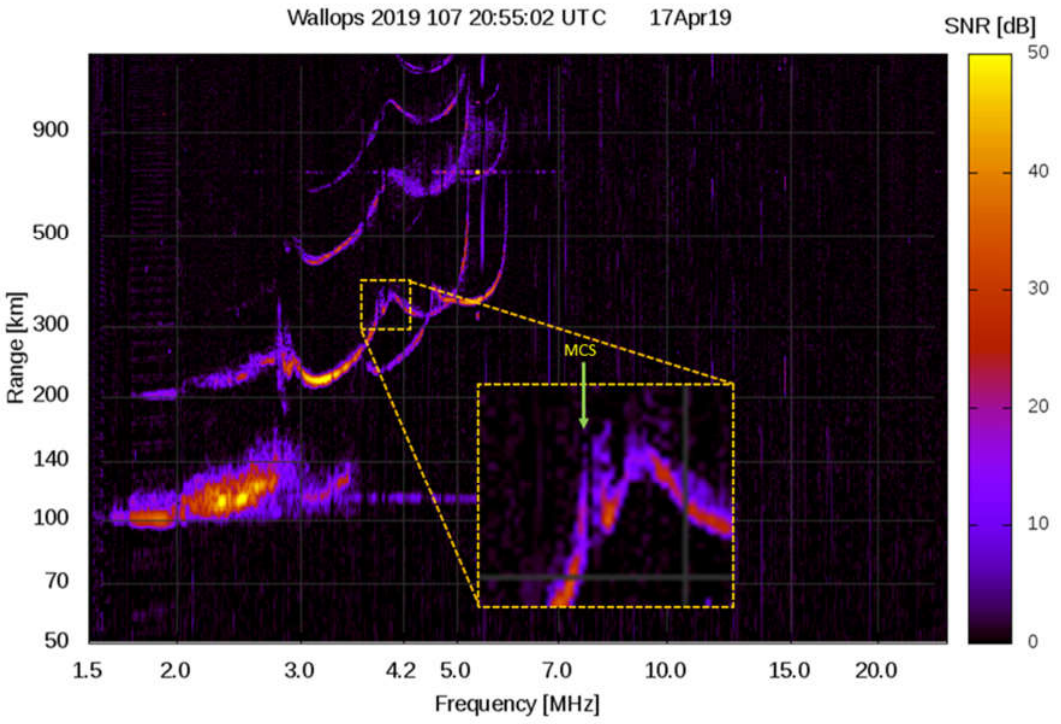
Figure 3. Sweep frequency ionogram when the NG-11 HAAW arrives at the fixed frequency observation altitude. An MCS is observed in the O-mode trace near 4 MHz.